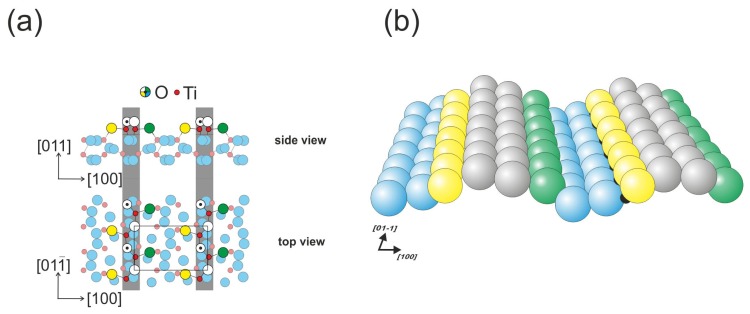
Rutile TiO2(011)-(2 × 1) surface: (a) top view and (b) perspective view.